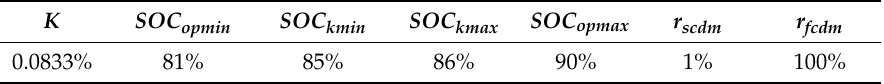
Table 3. Optimal parameters by suggested algorithm for convergence